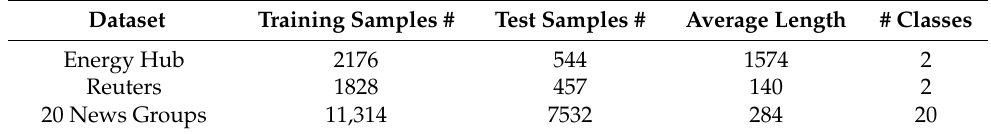
Table 1. Features of the three datasets used in these experiments. Energy-Hub is an in-house dataset, while Reuters and 20 News groups are widely used standard news classification datasets. Dataset Training Samples # Test Samples # Average Length # Classes Energy Hub 2176 544 1574 2 Reuters 1828